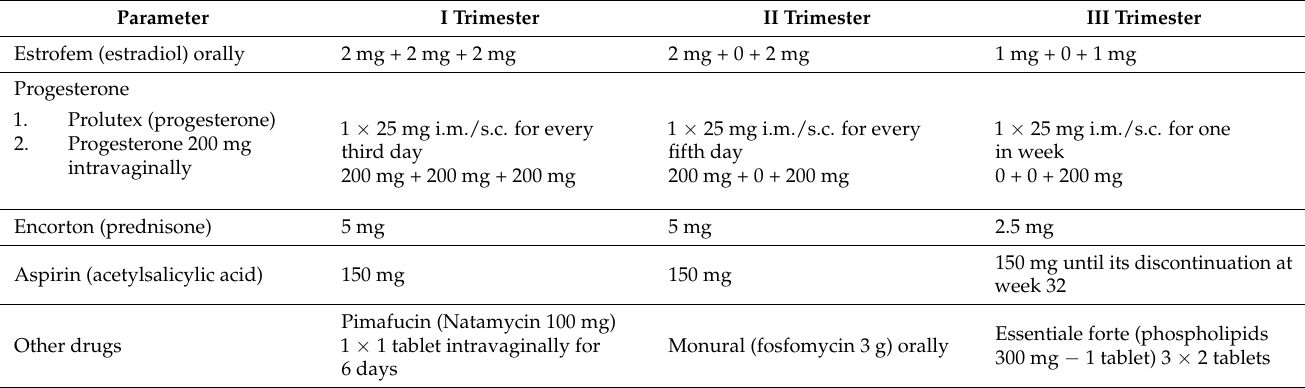
Table 1. Pharmacotherapy in the presented